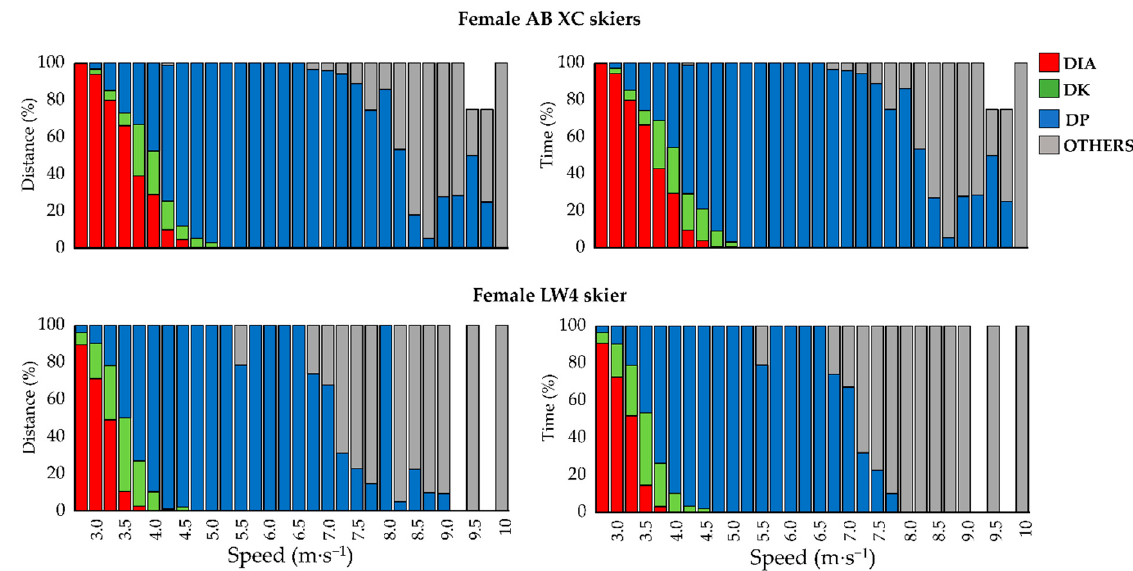
Figure 5. Distribution of sub-techniques over different speed-intervals for female AB and the LW4 XC skiers per distance and time. Diagonal stride (DIA; red); Kick double poling (DK; green); Double poling (DP; blue); Tuck position and turn technique (OTHER; gray). Blank sections for AB XC skiers and the LW4 XC skier illustrate that one of the skiers didn’t used these speeds.